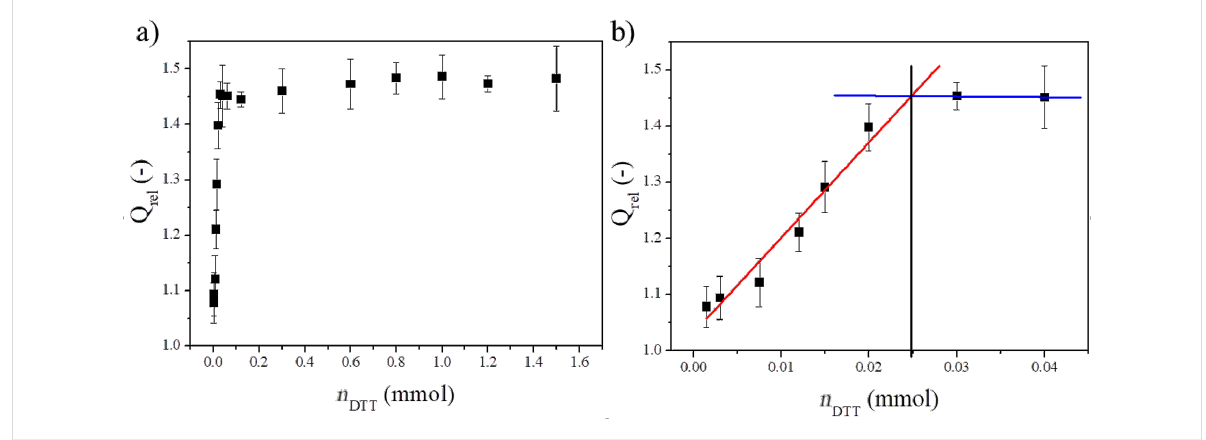
Figure 4: Dependence of the relative swelling degree of the PASP-20CYS-LYS gel on the amount of DTT a) between 0 and 1.6 mmol DDT and b) between 0 and 0.04 mmol DTT.